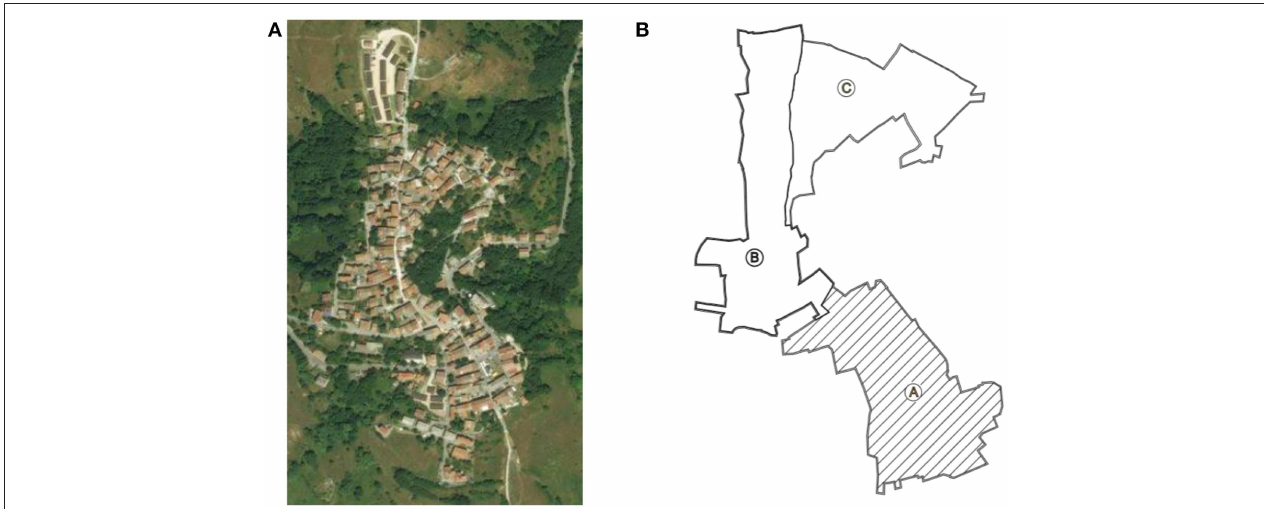
FIGURE 1 | Historic center of Campotosto: (A) Aerial photo (source: Google Earth) and (B) Territorial subdivision in areas according to the reconstruction plan of Campotosto drafted after 2009 L’Aquila earthquake (Ponzi et al., 2013).